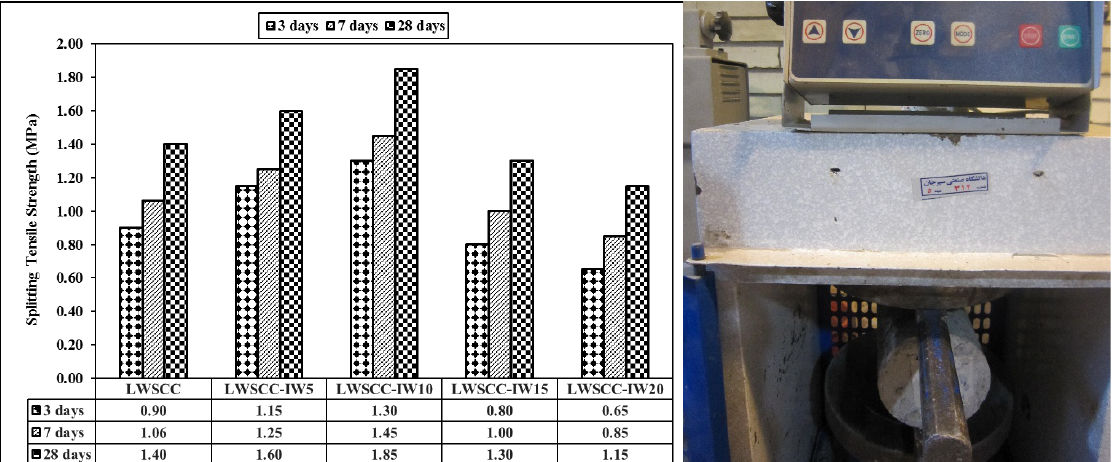
Figure 4 . Variation of splitting tensile strength of LWSCCs containing SMIW at different ages.